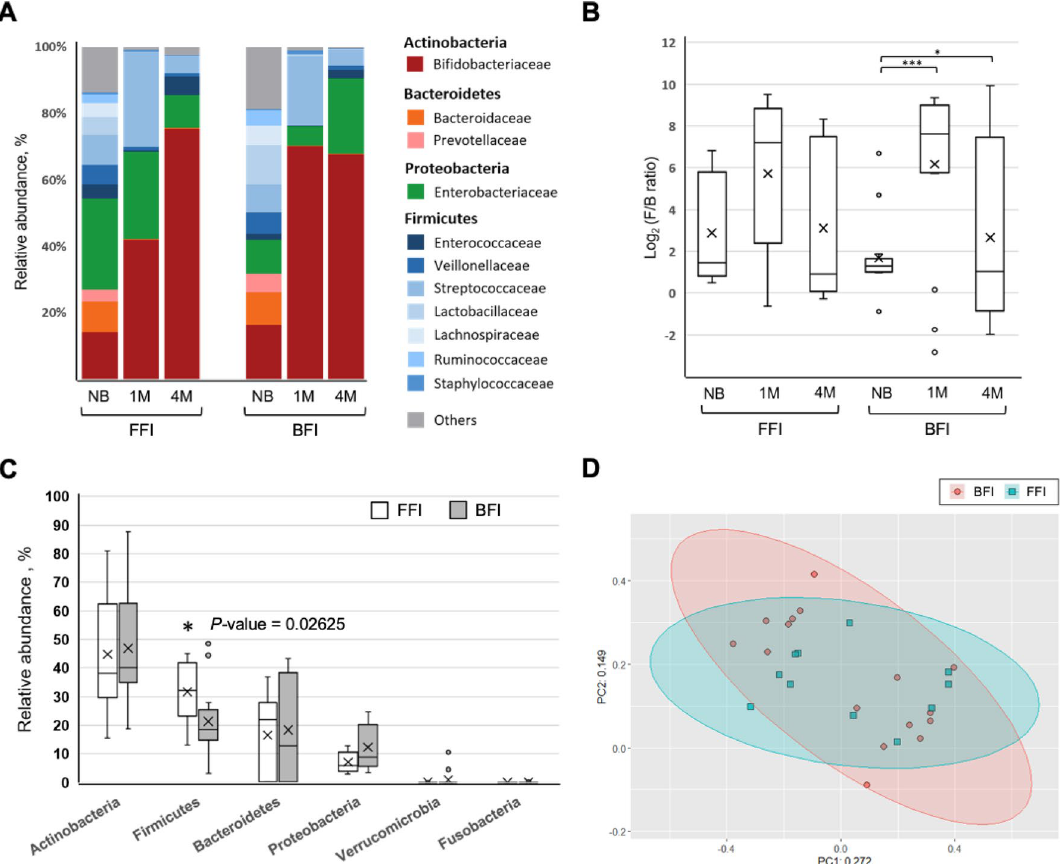
Figure 2. Comparison of relative abundances of microbial taxa between breast- and formula-fed infants. ( A ) Taxonomic distribution of bacterial communities at the family level ( B ) Box plot of log F/B ratio of the BFI and FFI groups. ( C ) Relative abundances of bacterial phyla within fecal microbiota of BF and FF infants at 4-month-old of age. ( D ) Principal Co-ordinate Analysis based on unweighted UniFrac distance of the OTUs in BFI and FFI samples at 4-month-old of age. Pairwise comparisons using Mann–Whitney test. *P < 0.05. **P < 0.0005. ***P < 0.00001.